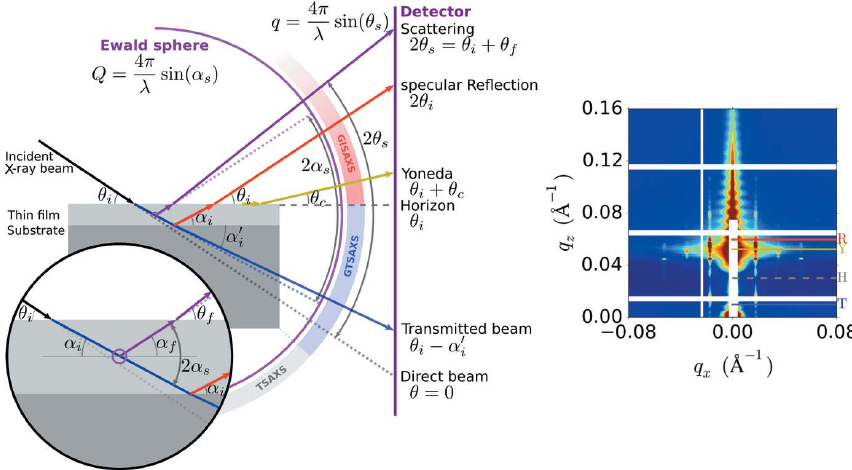
Figure 2 Experimental geometry for grazing-incidence scattering experiments. (Left) An incident X-ray beam (black) is refracted upon entering a thin film, and further refracted upon entering the substrate. Thus, the transmitted beam (blue) is shifted relative to the direct-beam position. Scattered rays (purple) are also refracted as they exit the film. As a result, a scattering event (purple ring) ¼ (cid:5) þ (cid:5) occurring with angle 2 (cid:5) in the sample’s reciprocal space ( Q ) is observed at a different s i f ¼ (cid:4) þ (cid:4) apparent scattering angle (2 (cid:4) ) and therefore experimentally measured on the detector at a s i f different reciprocal-space coordinate ( q ). (Right) An example GISAXS image, with the q noted for the transmitted beam (T), the horizon (H), the Yoneda (Y) and the specular reflected beam